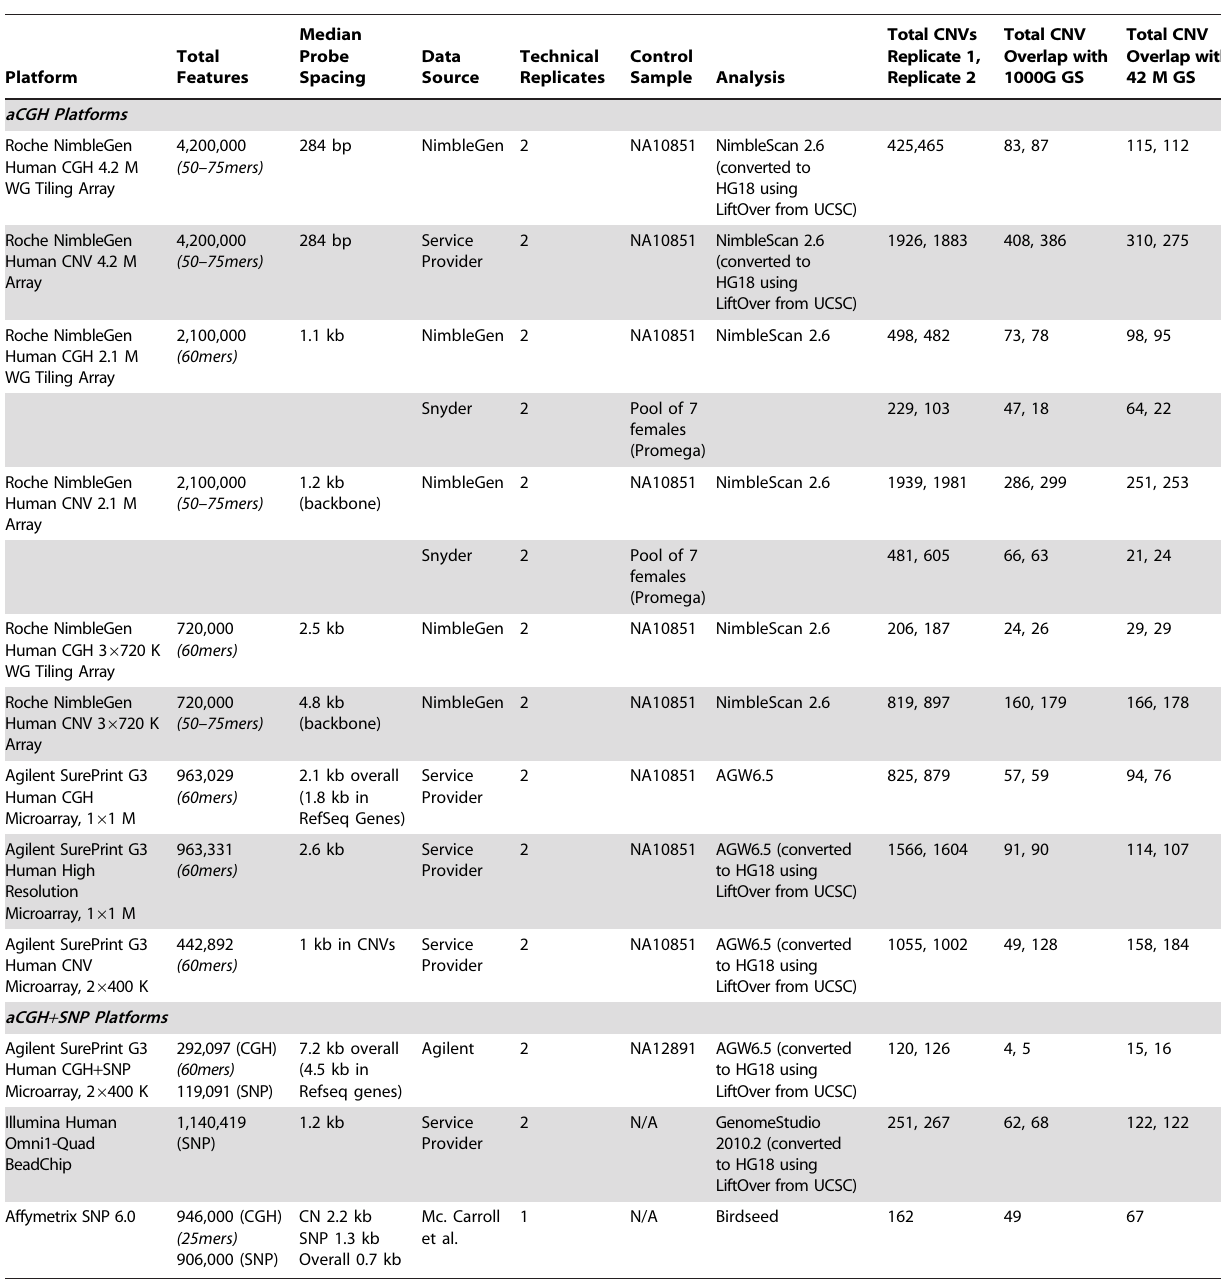
Table 1. Summary of CNV detection platforms and